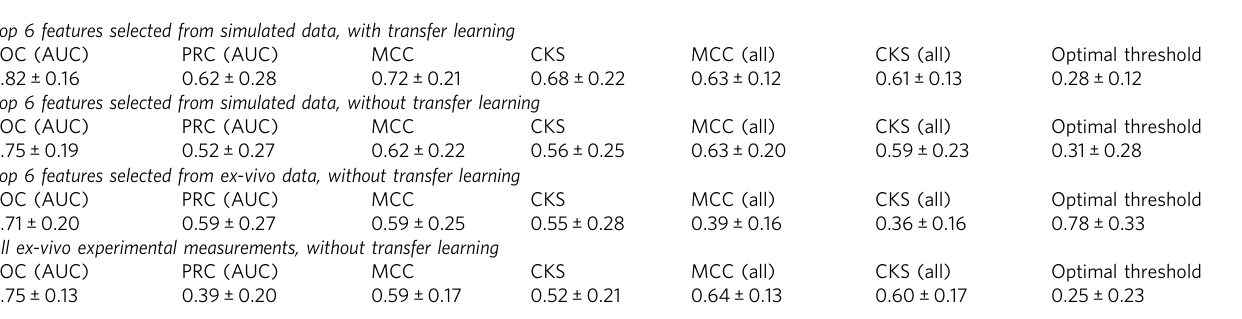
Table 4 Ex-vivo classi fi cation results from 10-fold cross validation using the top six experimentally accessible response features as inputs to the C-SBINN. Top 6 features selected from simulated data, with transfer learning ROC